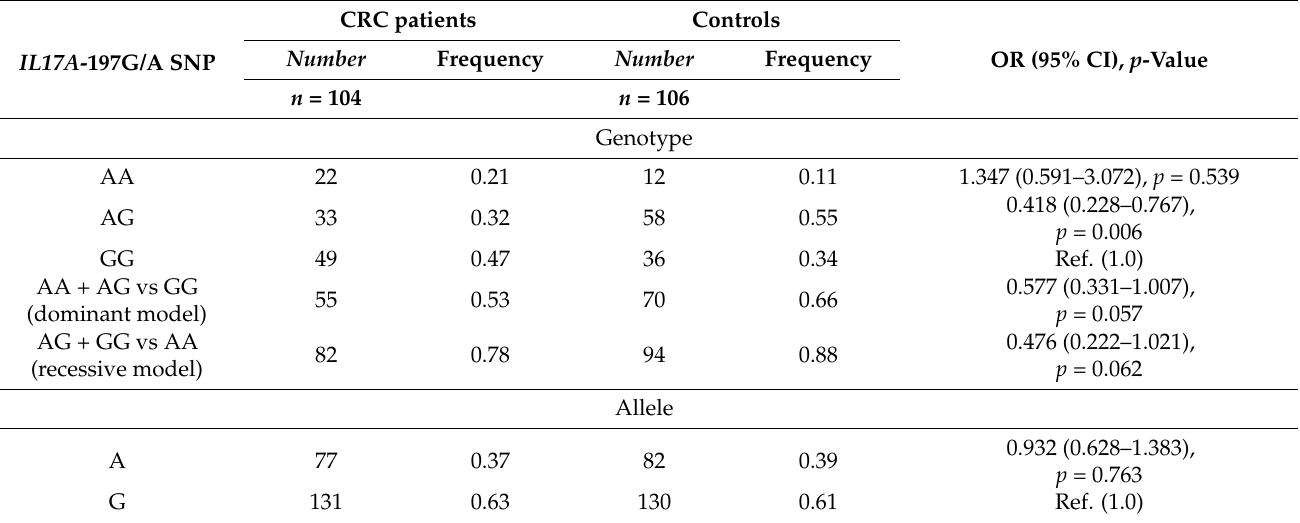
Table 3. Distribution of genotype and allelic frequencies of the IL17A -197 A/G SNP between CRC cases and controls.